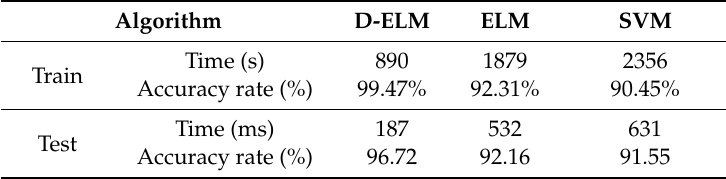
Table 4. Defect recognition of D-ELM ELM and SVM on wood images.